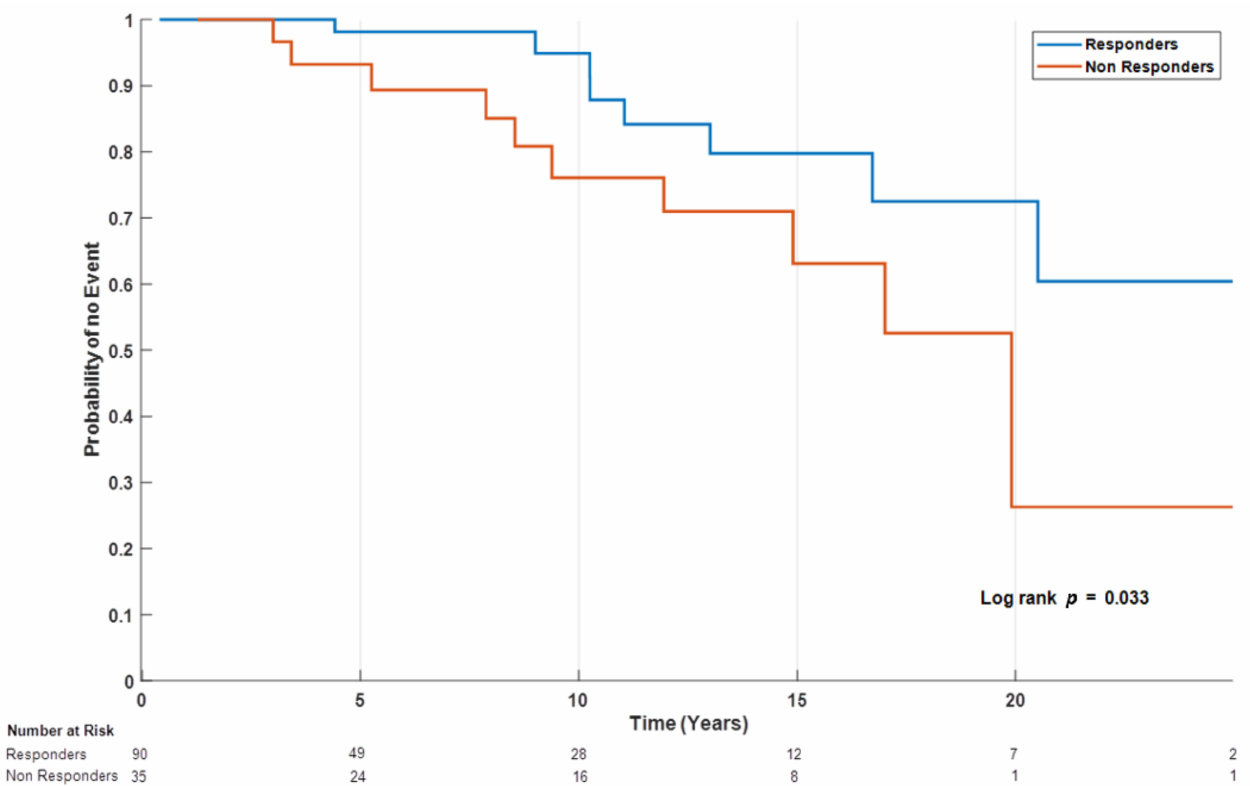
Figure 2. Kaplan–Meier survival curve to achieve any clinical endpoint in UDCA responder (blue line) versus non- responders (red line).